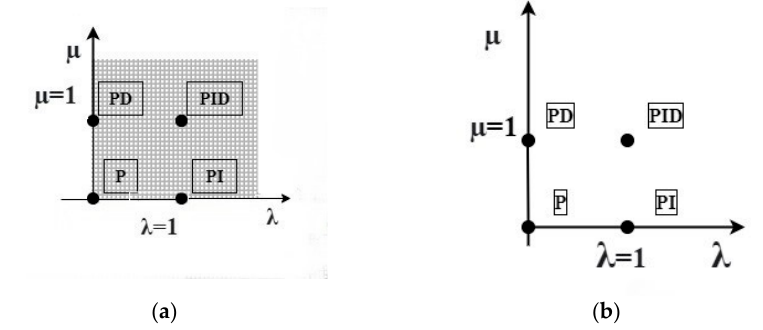
Figure 3. PID: ( a ) Classical order; ( b ) Fractional